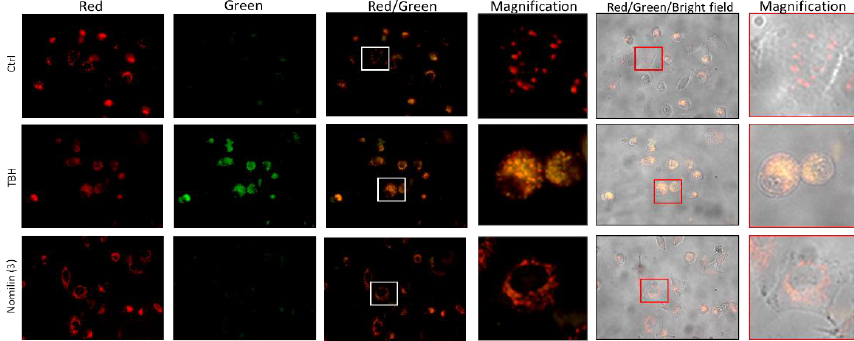
Figure 8. Mitochondrial membrane potential analysis of nomilin ( 3 ). Fluorescence microscope images of cells untreated (Ctrl) or treated with 500 µM of TBH alone or with nomilin ( 3 ) at 0.1 mg/mL for 2 h and submitted to JC-1 assay.